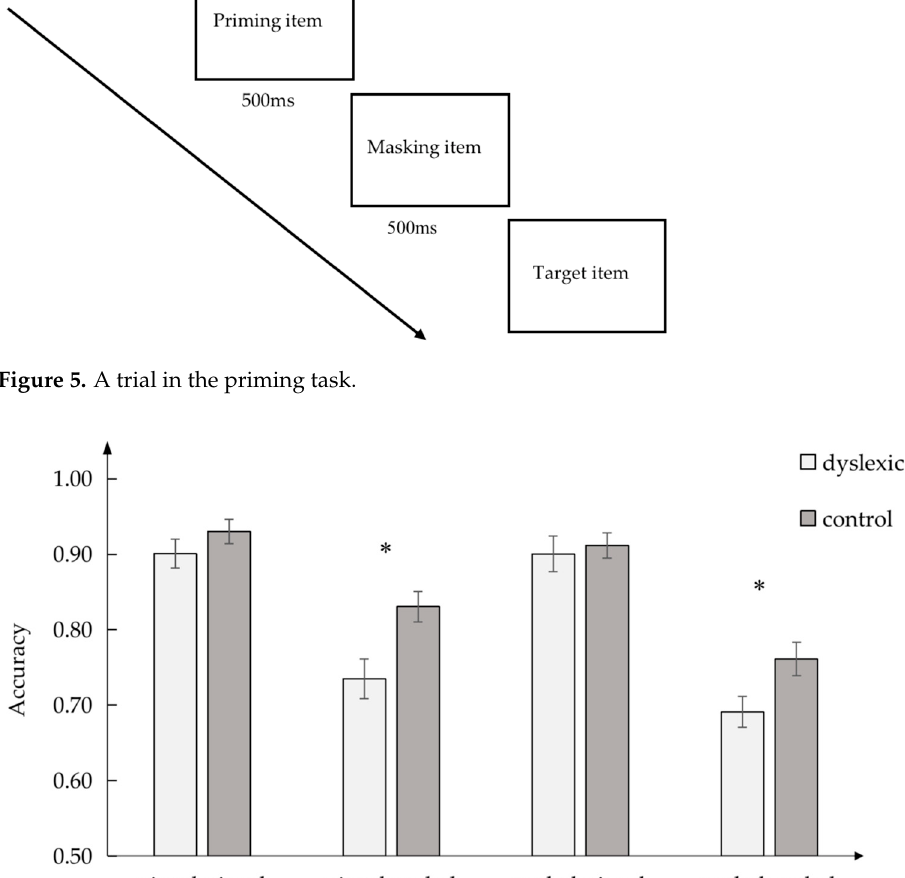
Figure 6. Accuracy in priming task in four PAL conditions between dyslexic and control groups; * p < 0.05.